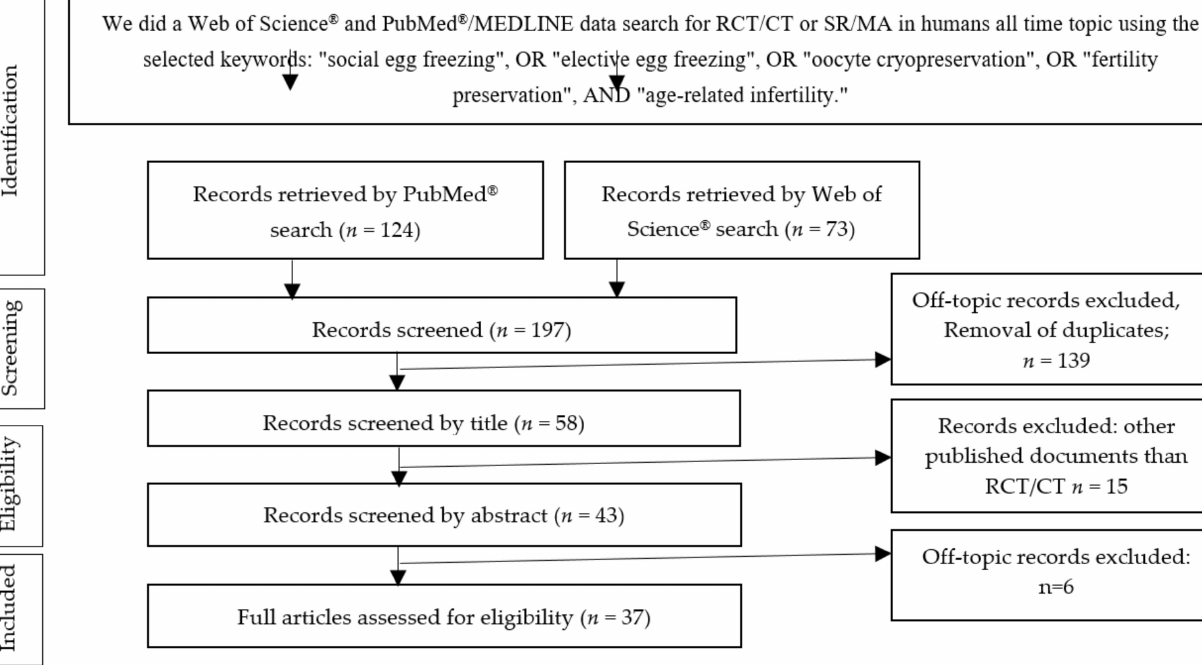
Figure 3. Preferred Reporting Items for Systematic Review and Meta-Analysis (PRISMA) diagram describing our systematic search and study selection process (RCT, randomized clinical trial; CT, clinical